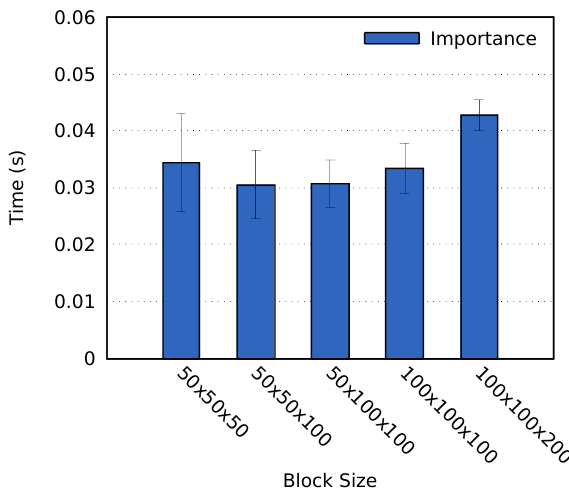
Figure 4. The average time required to perform the importance analysis for the MF data set on cluster A. The error bars display the standard deviation of the computation